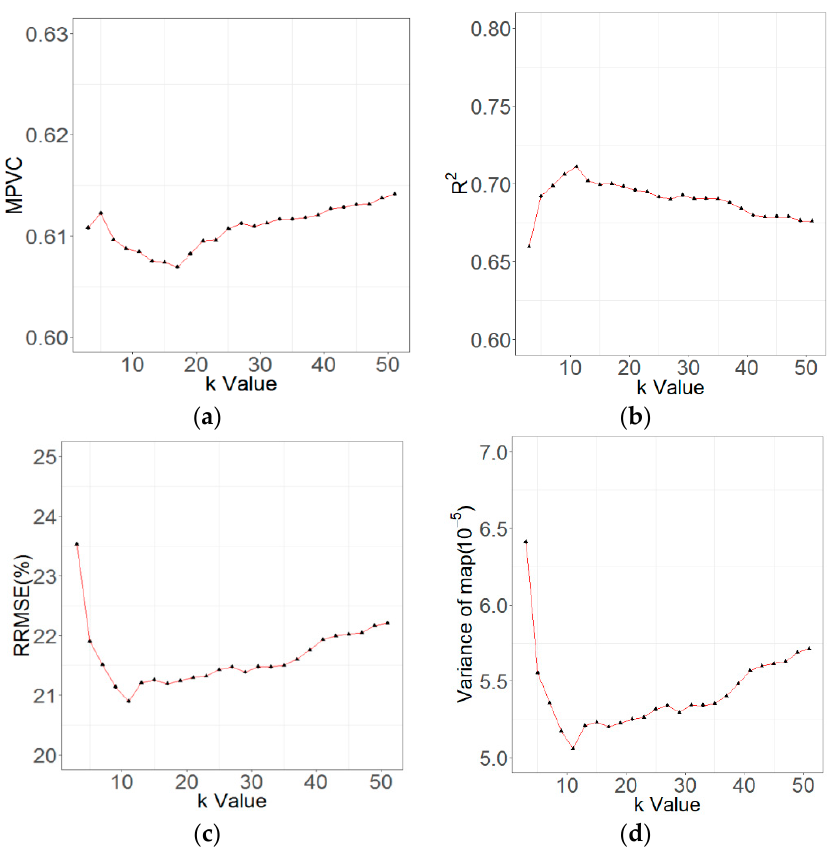
Figure 7. The accuracy assessment results of PVC predictions for Duolun County using Cons-kNN with 25 different k based on the test dataset: ( a ) mean prediction of plot percentage vegetation cover (MPVC) (confidence interval: 0.58–0.63); ( b ) coefficient of determination, R 2 ; ( c ) relative root mean square error (RRMSE); and ( d ) variance of the predicted PVC values for the maps ( VAR map